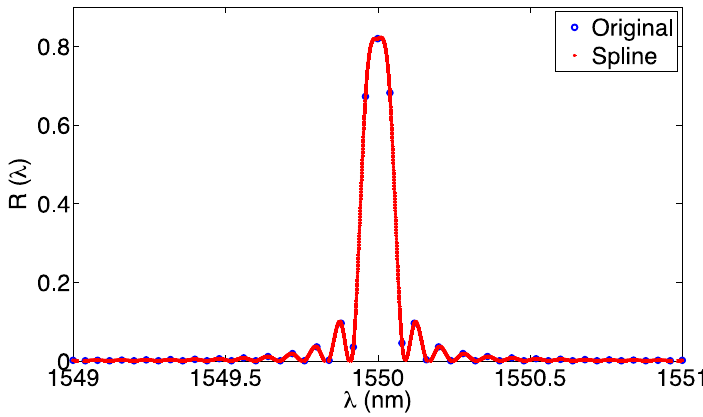
Figure 9. Sketch of the spline peak-tracking method. The original spectrum is sampled on a grid of 40 pm resolution, and interpolated with a cubic spline on a grid with 0.1 pm resolution.